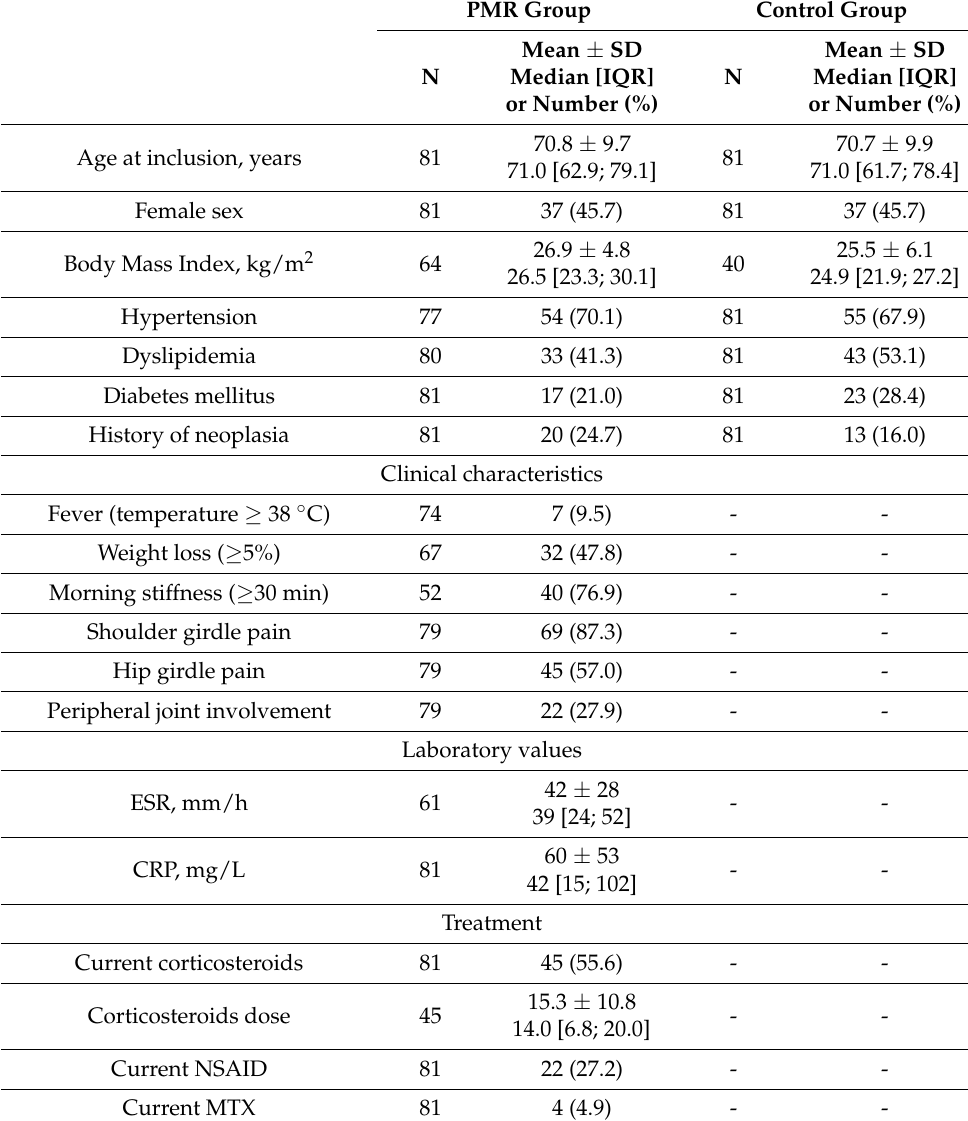
Table 1. Clinical characteristics of